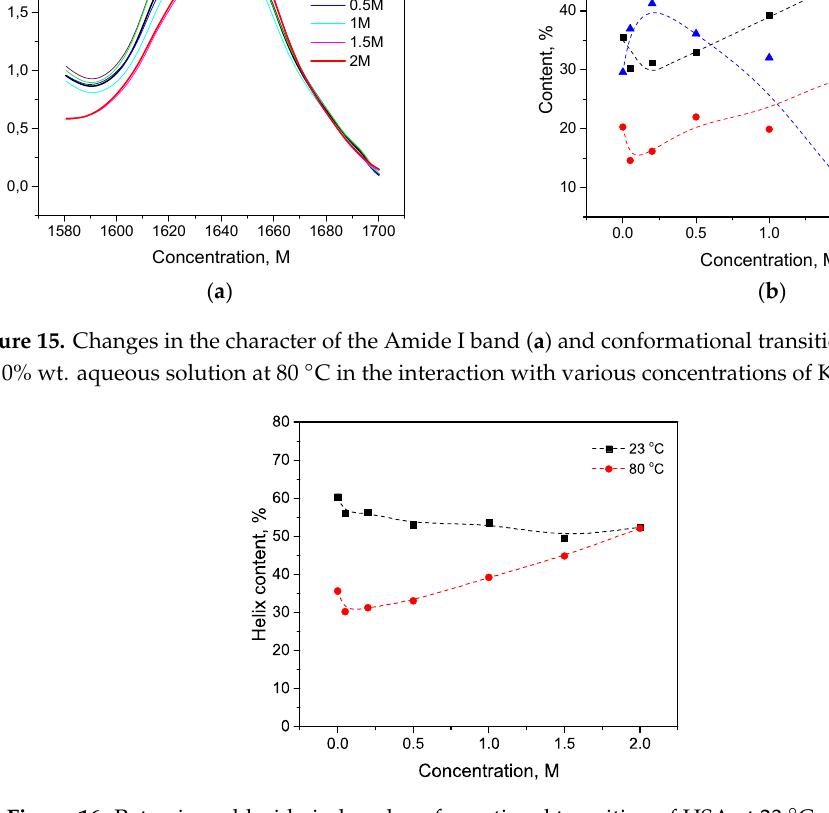
Figure 16. Potassium chloride-induced conformational transition of HSA at 23 °C and 80 °C.